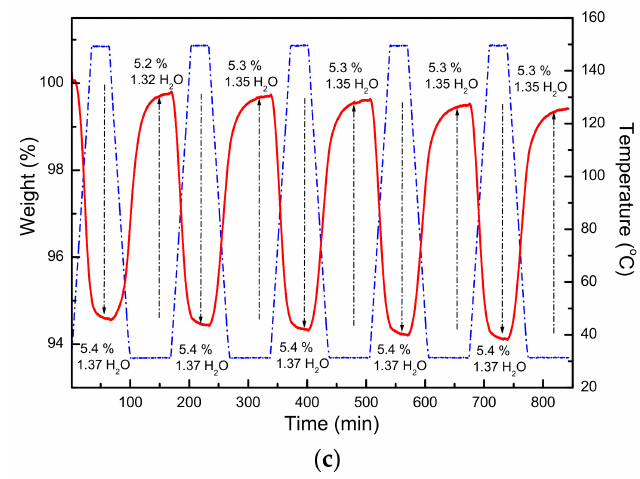
Figure 2. ( a ) Thermogravimetric analysis of compound 1 . ( b ) Simulation PXRD pattern obtained from single-crystal data and in situ PXRD patterns of compound 1 at selected temperatures. ( c ) Cyclic thermogravimetric measurements accompanied with the de-/rehydration processes repeated for five times.